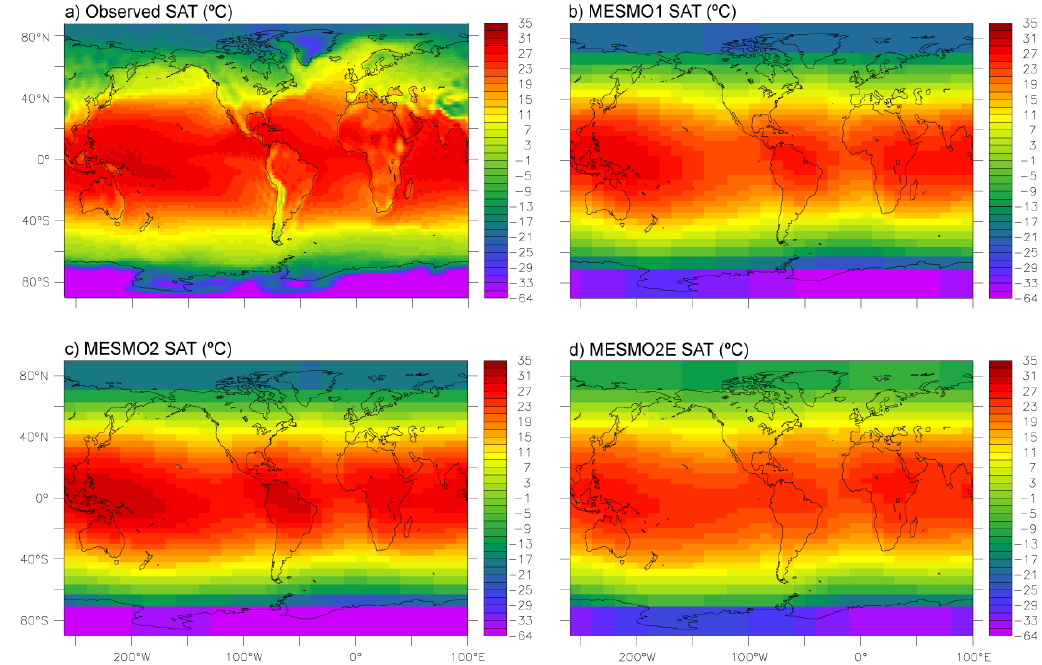
Fig. 4. Observed and model-simulated annual mean surface air temperature. Observations are based on the NCEP/NCAR 40yr reanalysis (Kalnay et al., 1996).